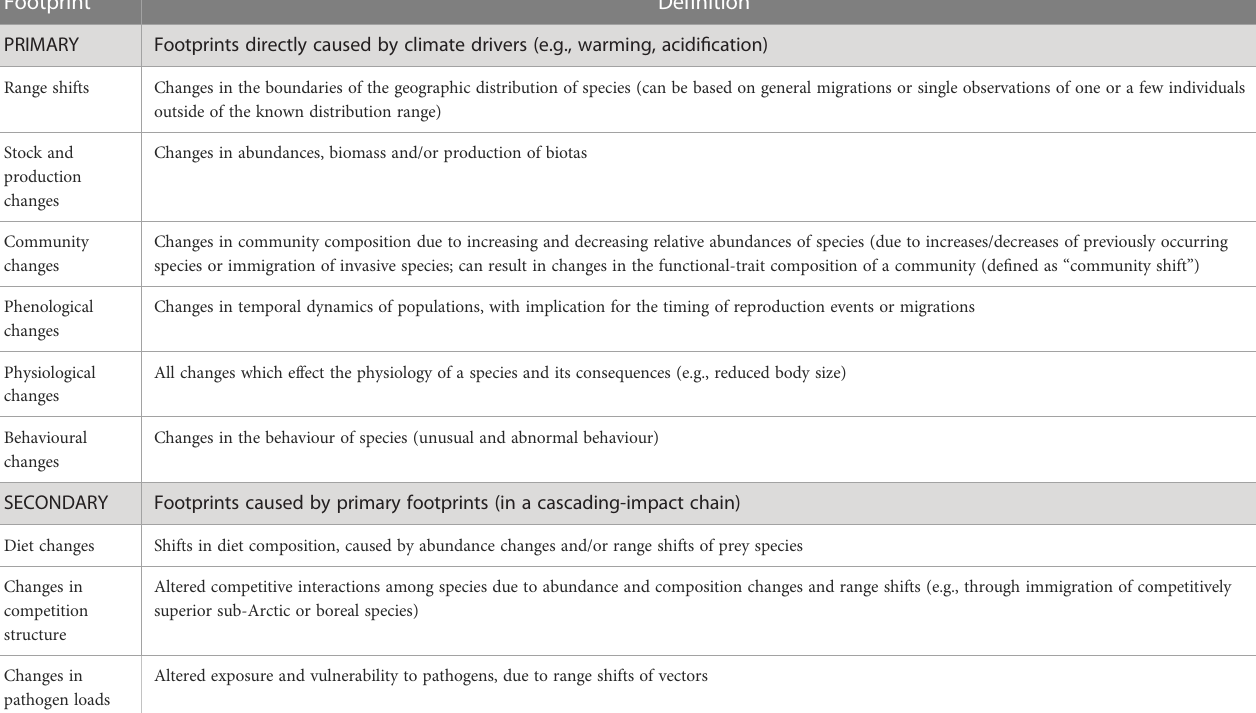
TABLE 1 De fi nition of primary and secondary footprints of climate change in Arctic marine ecosystems. Footprint De fi